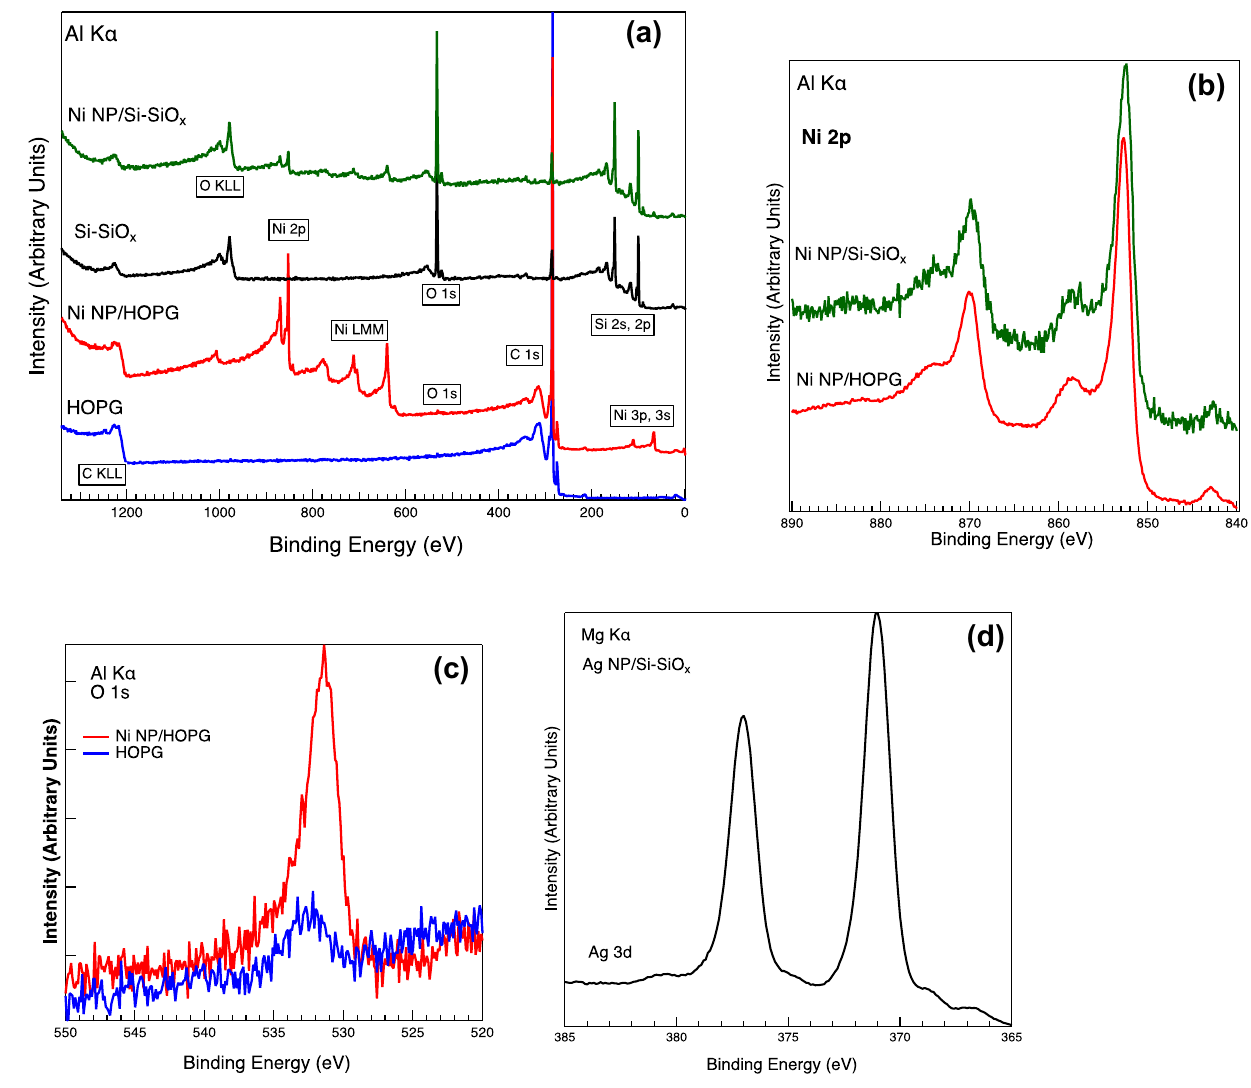
ing in oxygen amount, although the signal intensity is less than Fig. 4 a XPS spectra of HOPG, Si-SiO prior and after deposition of x 1% with respect to C 1 s. d Ag 3d spectrum from Ag NP deposited Ni NPs in the extended region. The major features appearing in the on Si-SiO spectra are labeled. b Ni 2p core levels spectra from Ni NPs, show- . Spectra reported on figures ( a ) to ( c ) were obtained x ing the typical metal-like features distinctive of clean Ni. The two using Al Kα photons (hn ν= 1486.7 eV), while spectrum on ( d ) was spectra are normalized to their maxima. c O 1 s core level spectra obtained with Mg Kα photons (hν = 1253.6 prior and after deposition of NPs on HOPG, showing and increas-